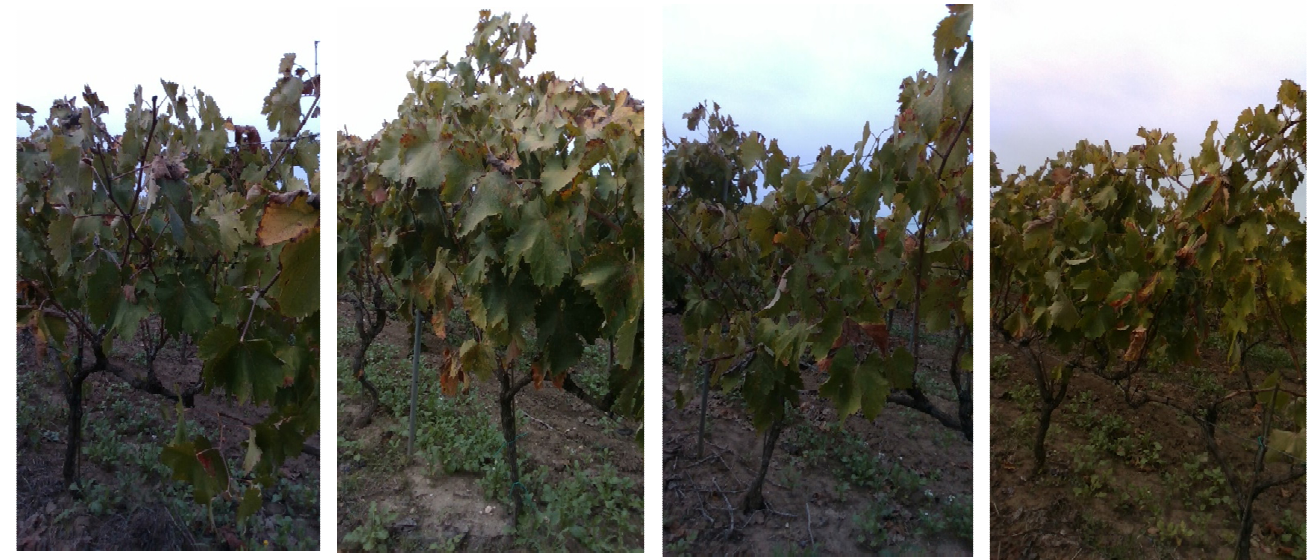
Figure 10. True negative images acquired in a vineyard used for TNA training.